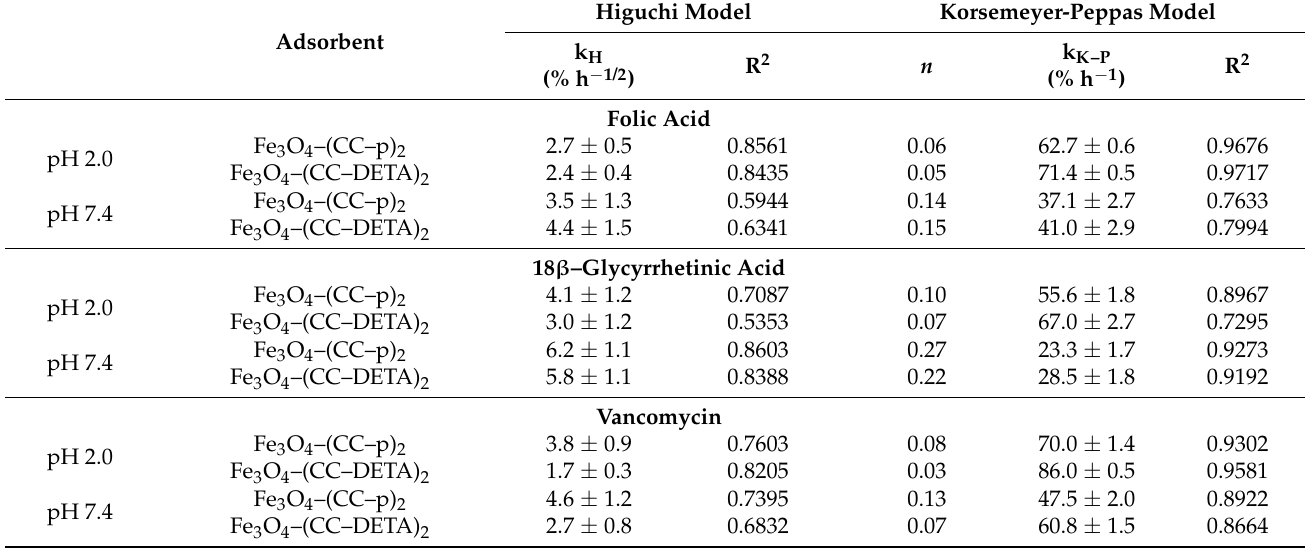
Table 4. The parameters of the biocompounds’ releases from the materials functionalized with triazine dendrons of generation G2 (Fe 3 O 4 –(CC–p) 2 and Fe 3 O 4 –(CC–DETA) 2 ) in pH 2.0 and pH 7.4, calculated for the first-order, the Higuchi, and the Korsmeyer–Peppas release